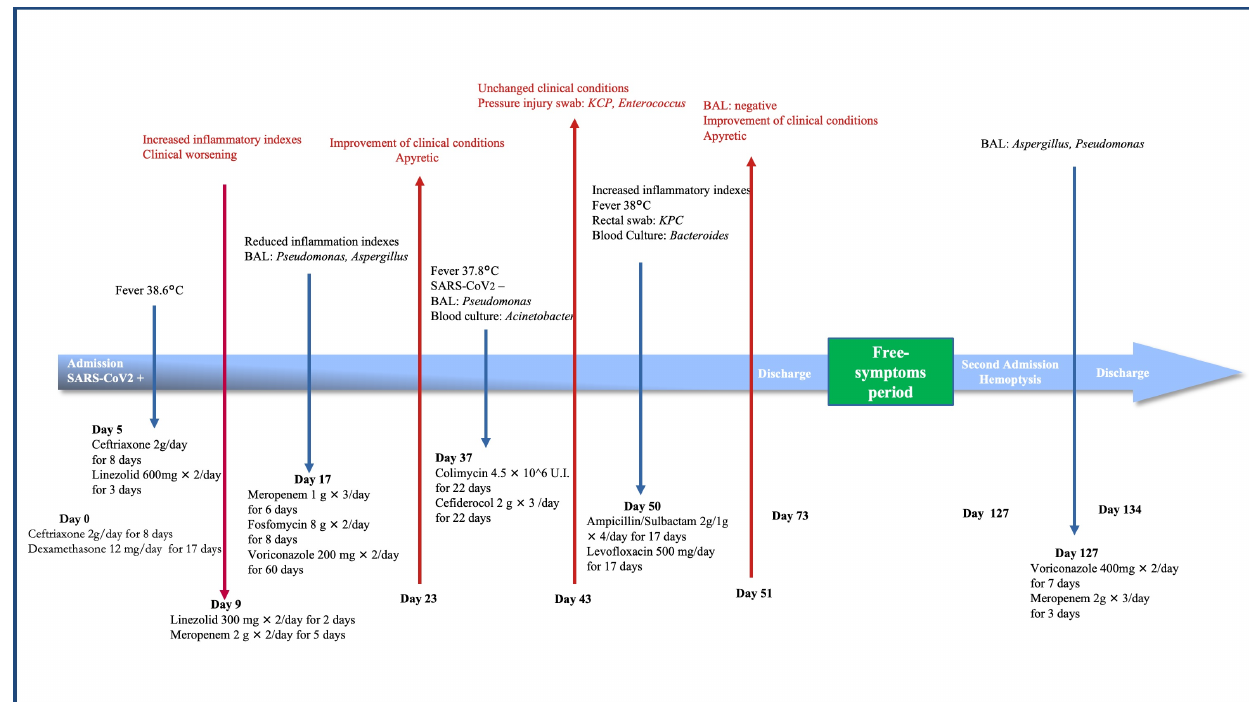
Figure 1. Timeline of disease progression and patient’s clinical course. Legend: thin red arrows pointing up show the response to the treatment initiated due to changes within the clinical condition of the patient, which are represented by thin blue arrows pointing down. His nasal swab tested negative for SARS-CoV-2 on day 37. After two months of ICU stay, the patient’s respiratory condition improved, and he was successfully discharged to